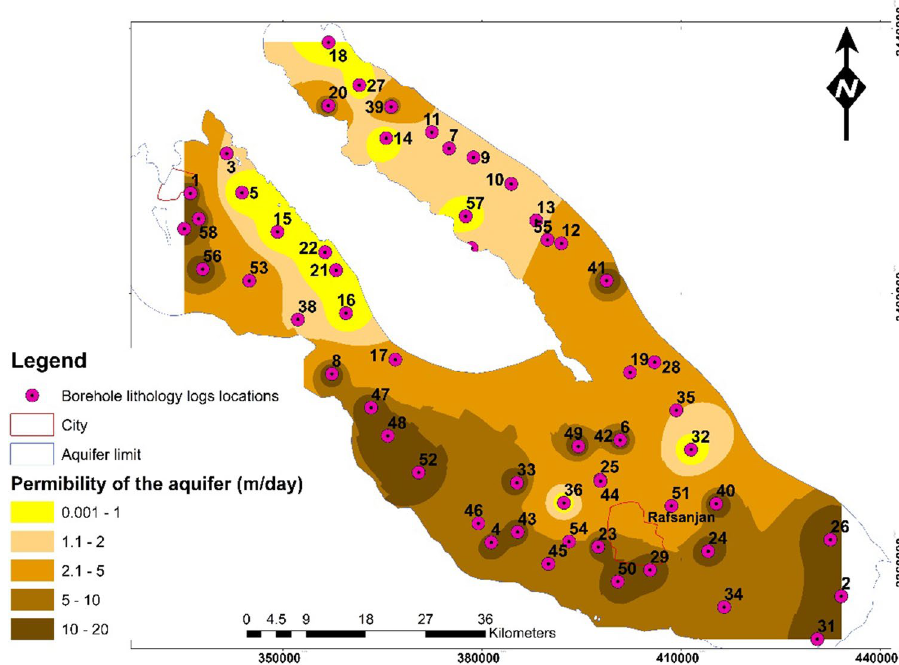
Fig. 5 Permeability of the aqui- fer in the study area